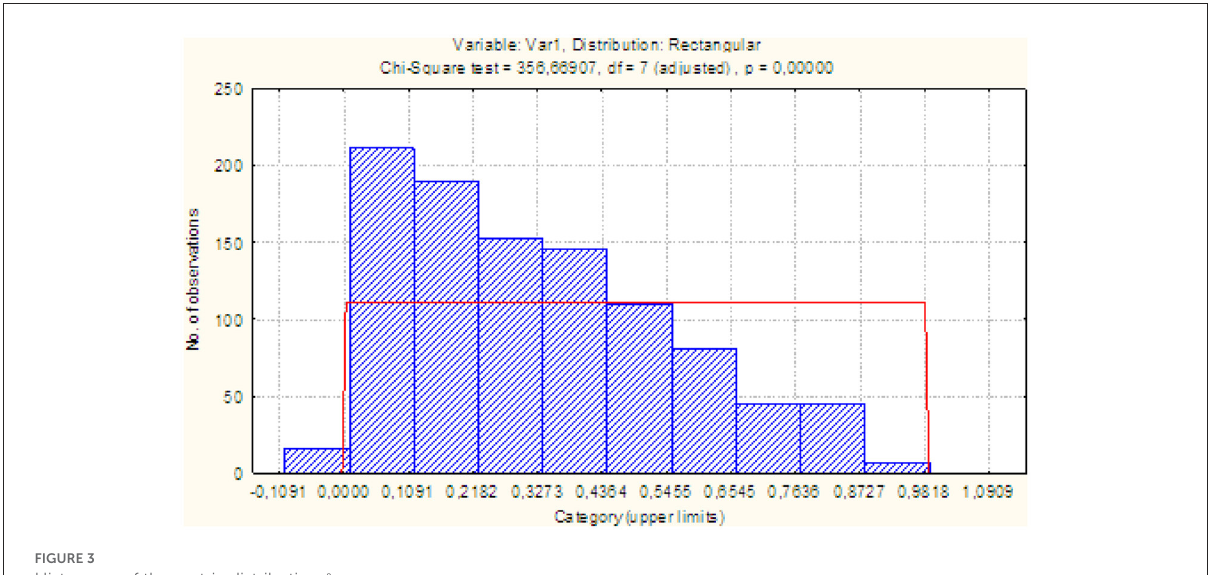
FIGURE3 Histogram of the metric distribution δ 2